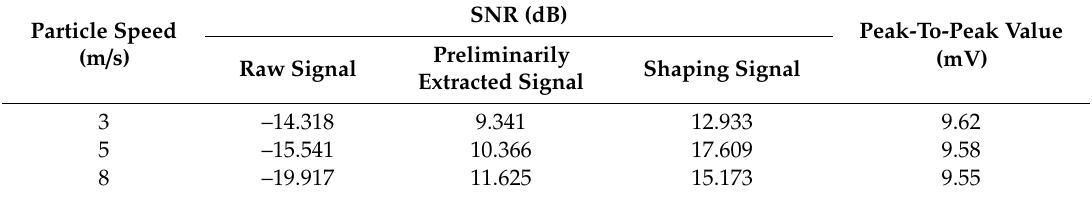
Figure 11. The signal of particles with different speeds. ( a ) The preliminarily extracted particle signals and ( b ) the shaped particle signals. Table 4. The signal-to-noise ratio (SNR) of real signals.